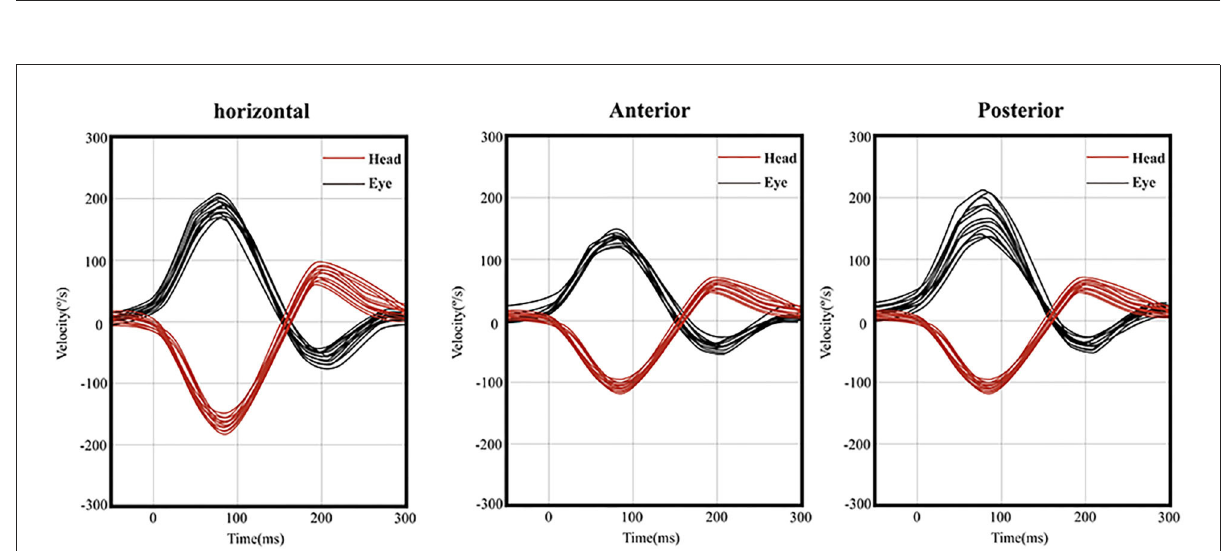
FIGURE3 Normal vHIT on the right side of one patient. (left) Instantaneous VOR gain at 60ms for the horizontal canal was 1.02 and showed no corrective saccades. (middle) Regression VOR gain for the anterior canal was 1.06 and showed no corrective saccades. (right) Regression VOR gain for the posterior canal was 1.45 and showed no corrective